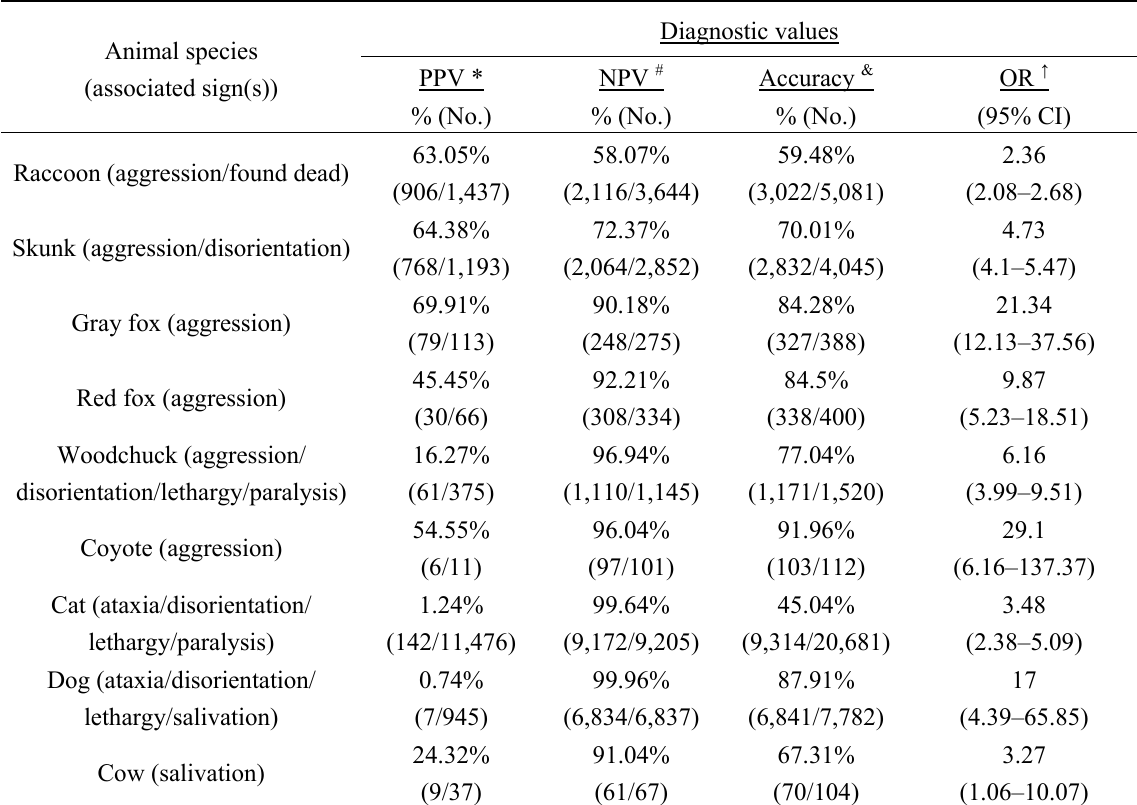
Table 2. Predictive value of one or more reported clinical signs in the identification of RRV virus infection, by animal species, Massachusetts,